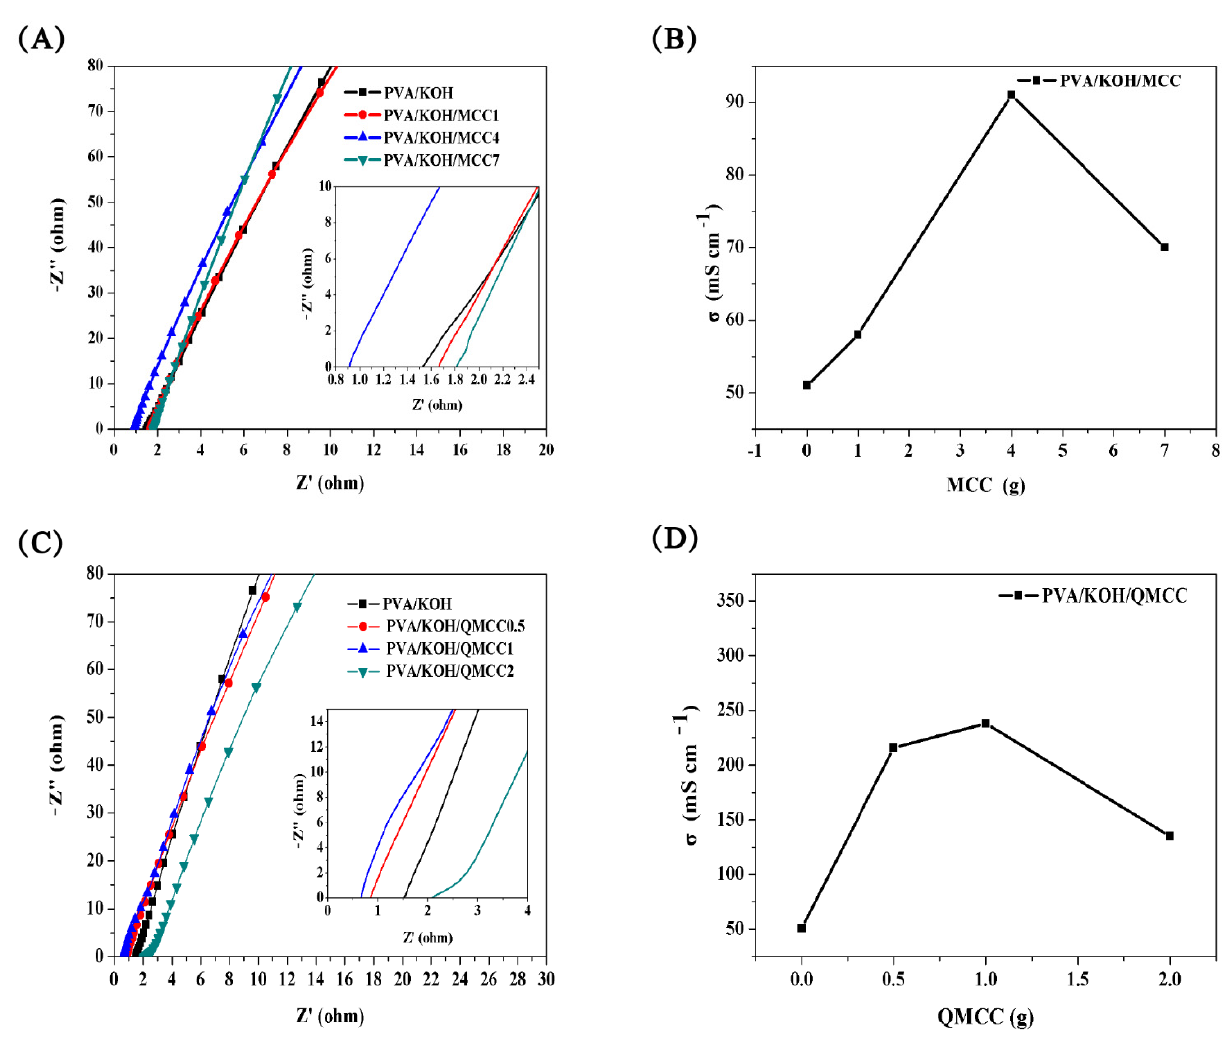
Figure 6. ( A ) AC impedance curve of PVA/KOH and PVA/KOH/MCC alkaline electrolyte membranes. ( B ) Conductivity of PVA/KOH/MCC alkaline electrolyte membranes. ( C ) AC impedance curve of PVA/KOH/QMCC alkaline electrolyte membranes. ( D ) Conductivity of PVA/KOH/QMCC alkaline electrolyte membranes. The AC impedance curve of the composite membrane was tested using an electrochem- ical workstation, and the test results are shown in Figure 6A,C. From the AC